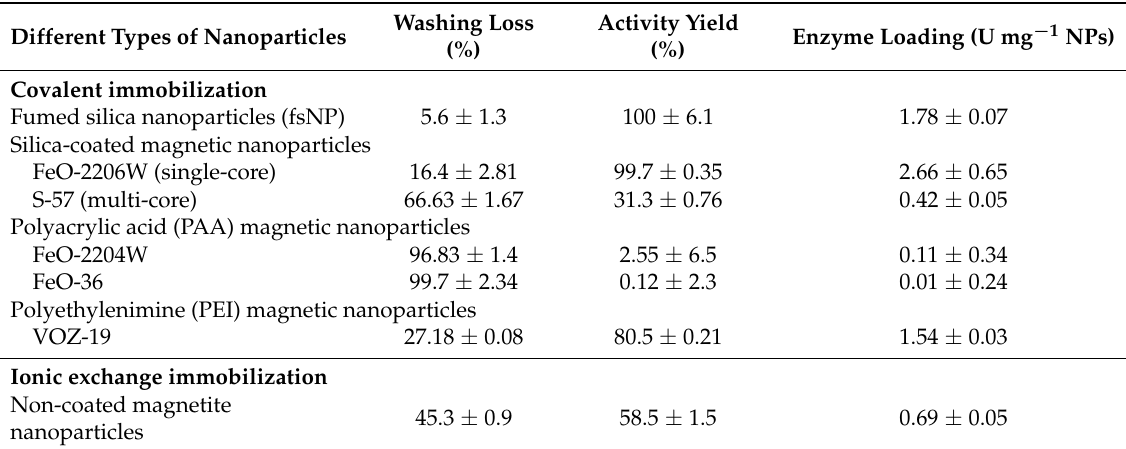
Table 2. Activity yield, washing loss, and enzyme loading for the optimal doses in the immobilization